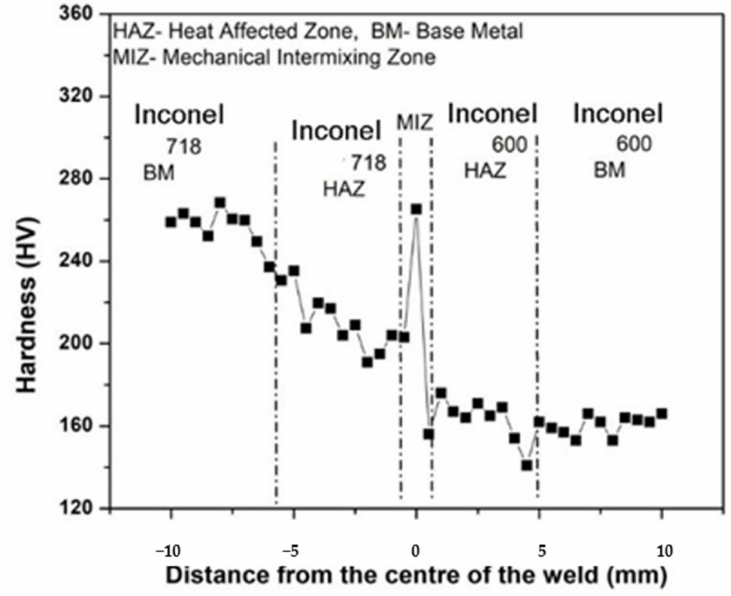
Figure 4. Vickers microhardness profile across the Inconel 718/Inconel 600 dissimilar friction